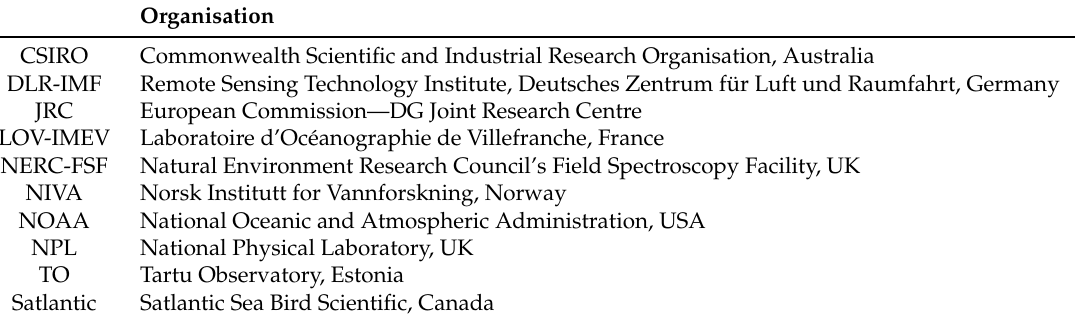
Table 1. Laboratories that participated in the measurements (Alphabetic